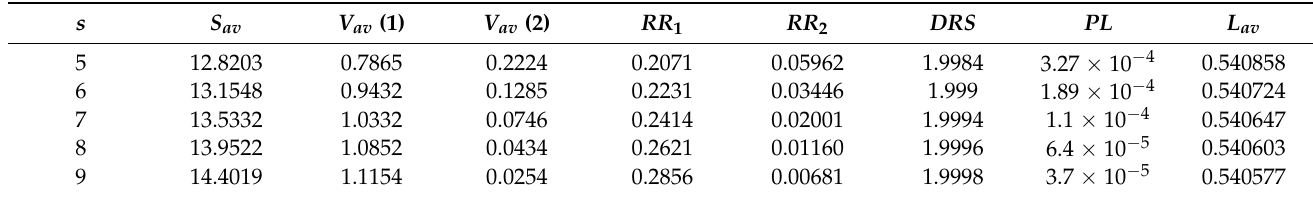
Table 8. Dependence of the performance measures on parameter s ; λ = 2, µ 1 = 5, µ 2 = 6, κ = 2, ν 1 = 3, ν 2 = 5, τ = 2, r = 3, S = 21.